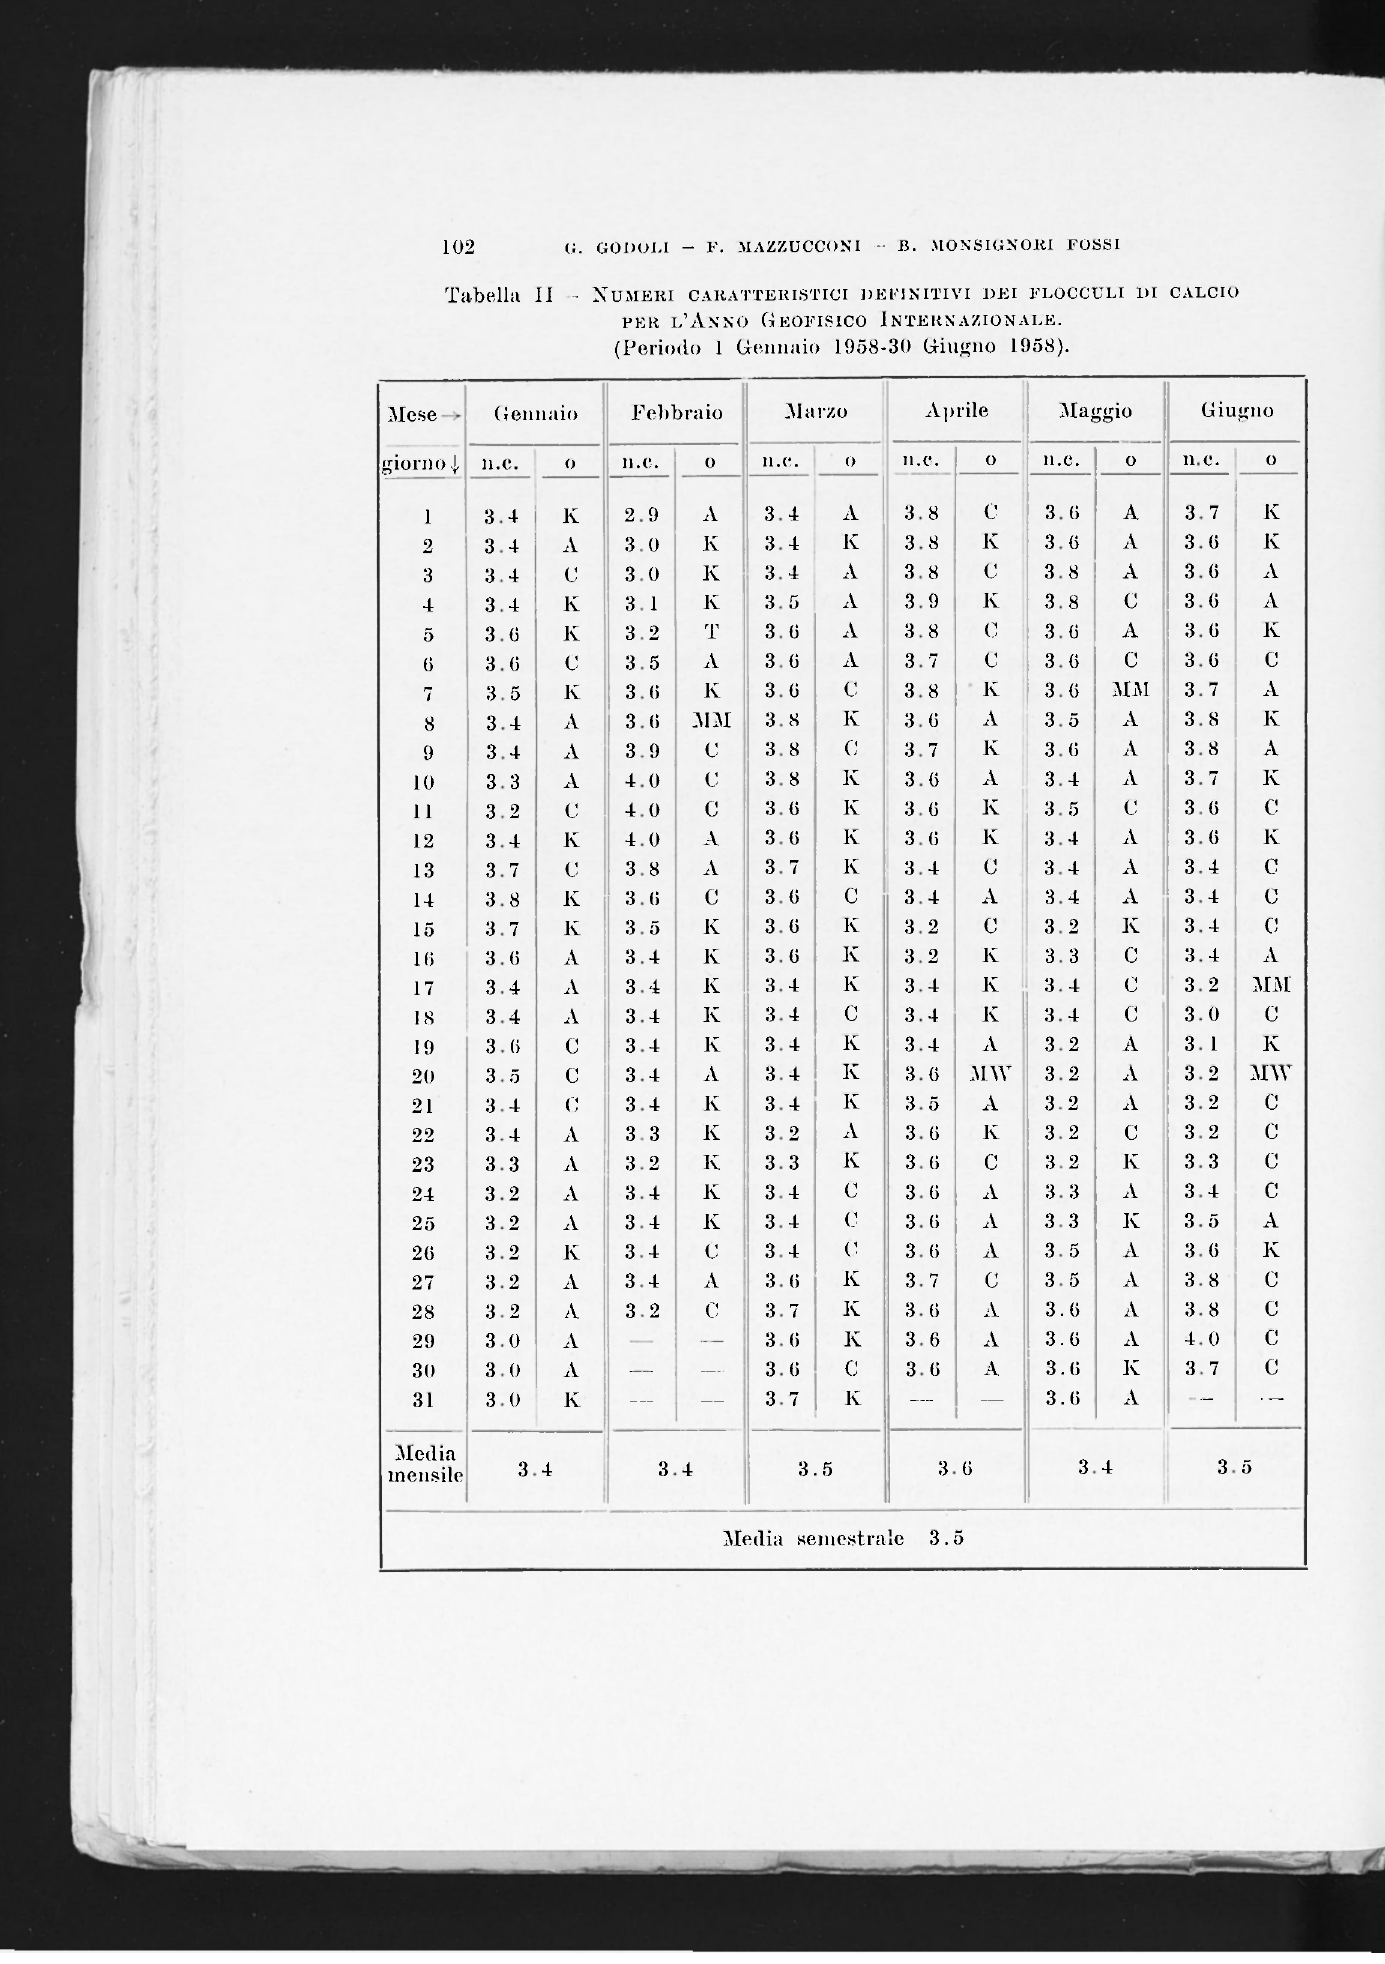
G. G0DOLI - F. MAZZUCCONI - ß. MONSIGNORI FOSSI Tabella II - NUMERI CARATTERISTICI DEFINITIVI DEI FLOCCULI DI CALCIO PER L'ANNO GEOFÍSICO INTERNAZIONALE. (Periodo 1 Gennaio 1958-30 Giugno